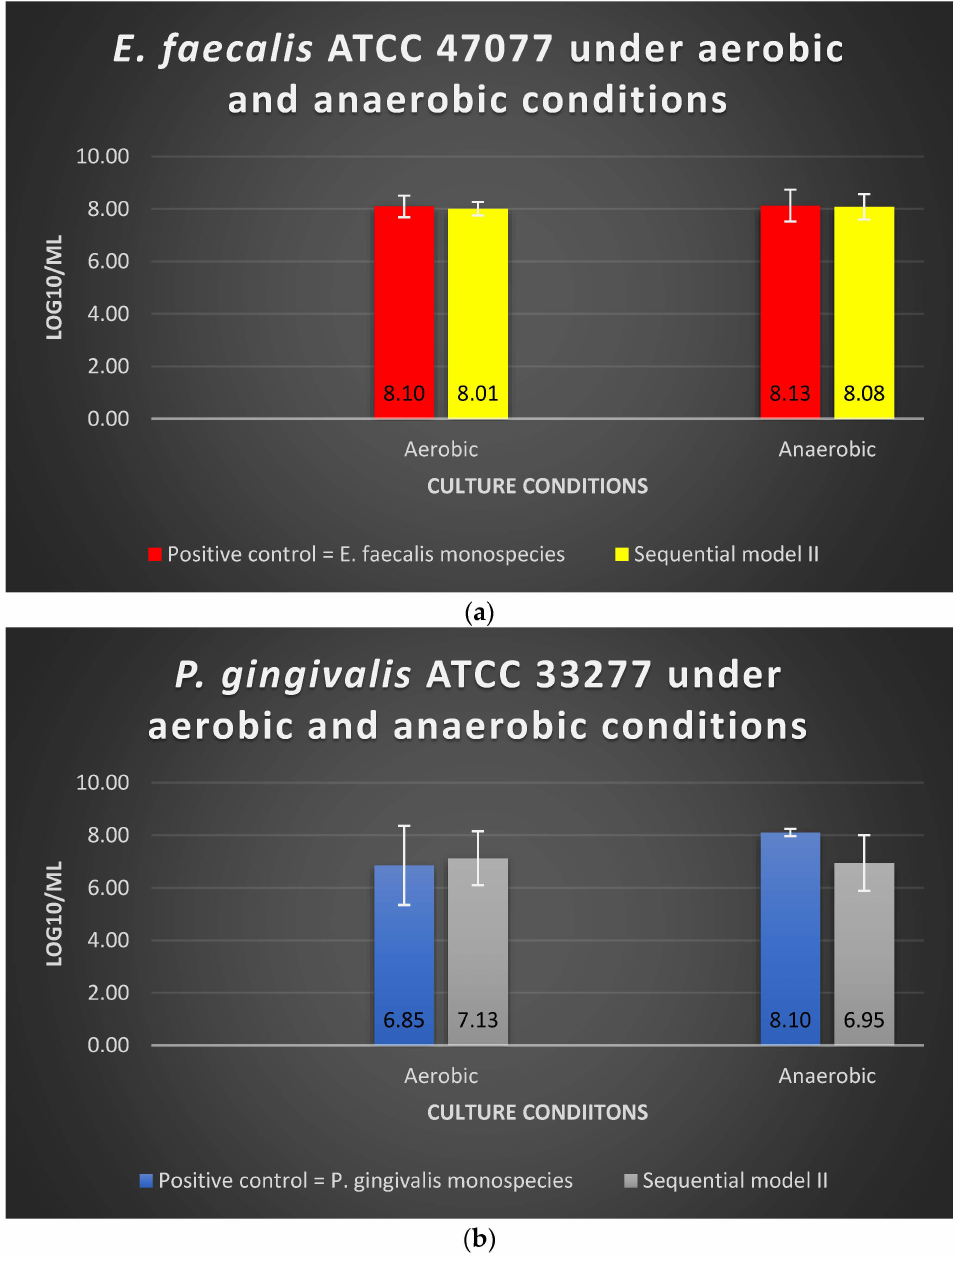
Figure 2. The viability of ( a ) E. faecalis and ( b ) P. gingivalis , cultured independently under aerobic and anaerobic conditions based on Sequential model II and mono-culture models. Data represent the mean and standard